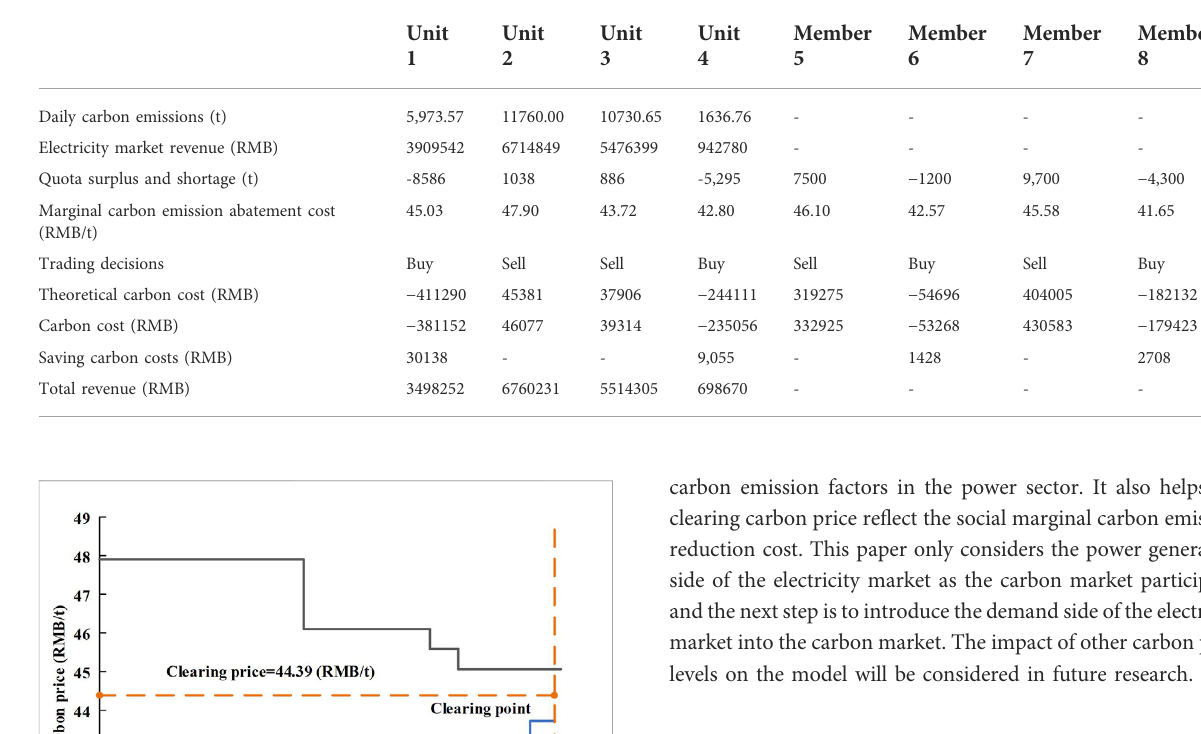
TABLE 7 Information and market revenue of electricity market and carbon market members.